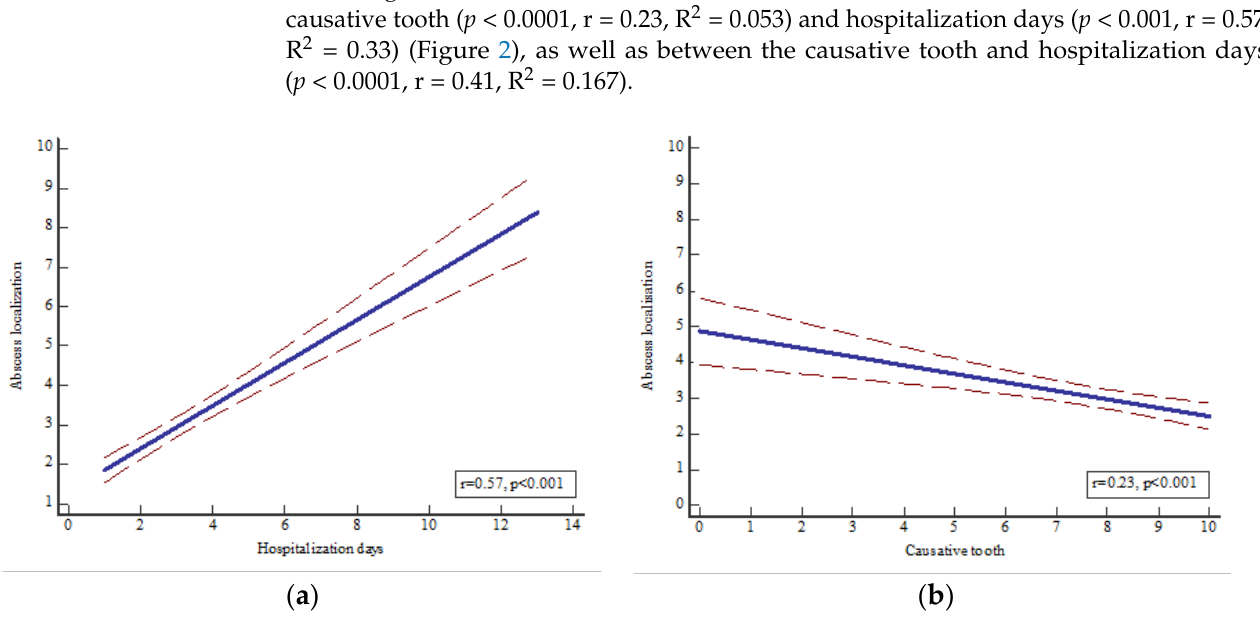
Figure 2. Significant association between ( a ) OA localization and hospitalization days ( p < 0.001, r = 0.57, R 2 = 0.33) and ( b ) causative tooth ( p < 0.0001, r = 0.23, R 2 = 0.053). A 95% confidence